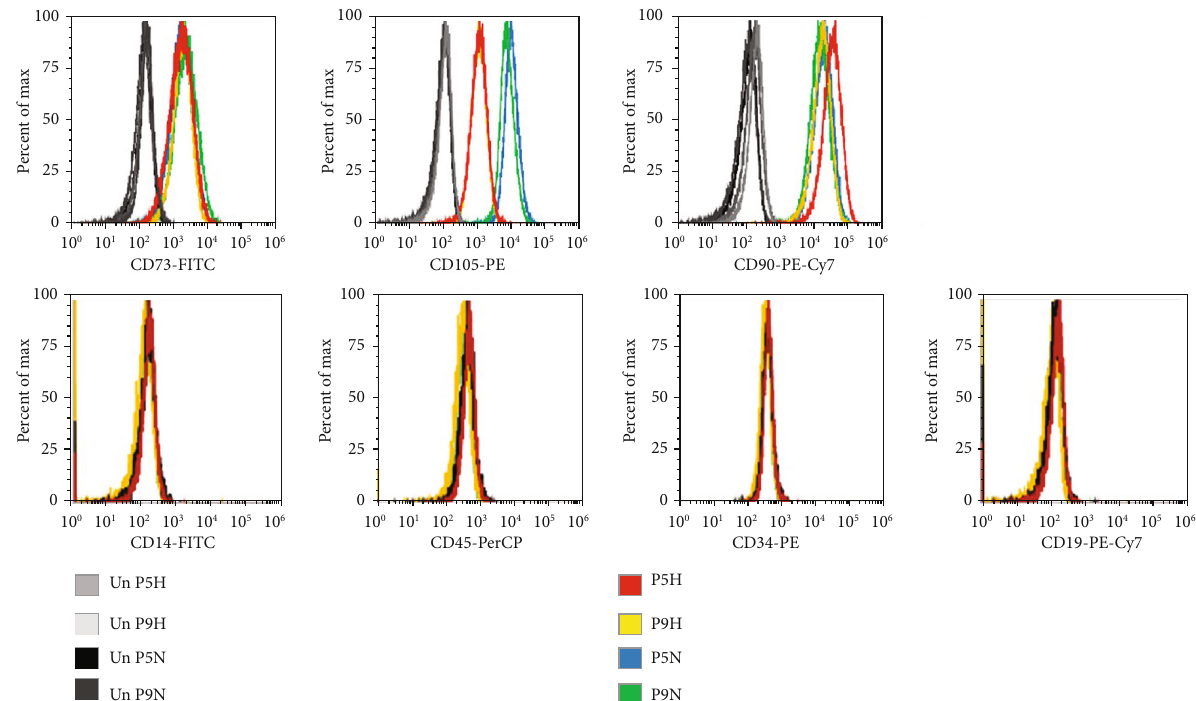
Figure 2: Flow cytometry of CD cell surface markers for cells cultured under hypoxia and normoxia. The positive CD markers for MSCs as detected by the fl uorescent antibodies anti-CD73 FITC, anti-CD105 PE, and anti-CD90 PE Cy7. The negative markers of MSCs were detected using anti-CD14 FITC, anti-CD45 PerCP, anti-CD34-R-PE, and anti-CD19 PE-Cy7 antibodies. Unstained cell for each condition was used as negative